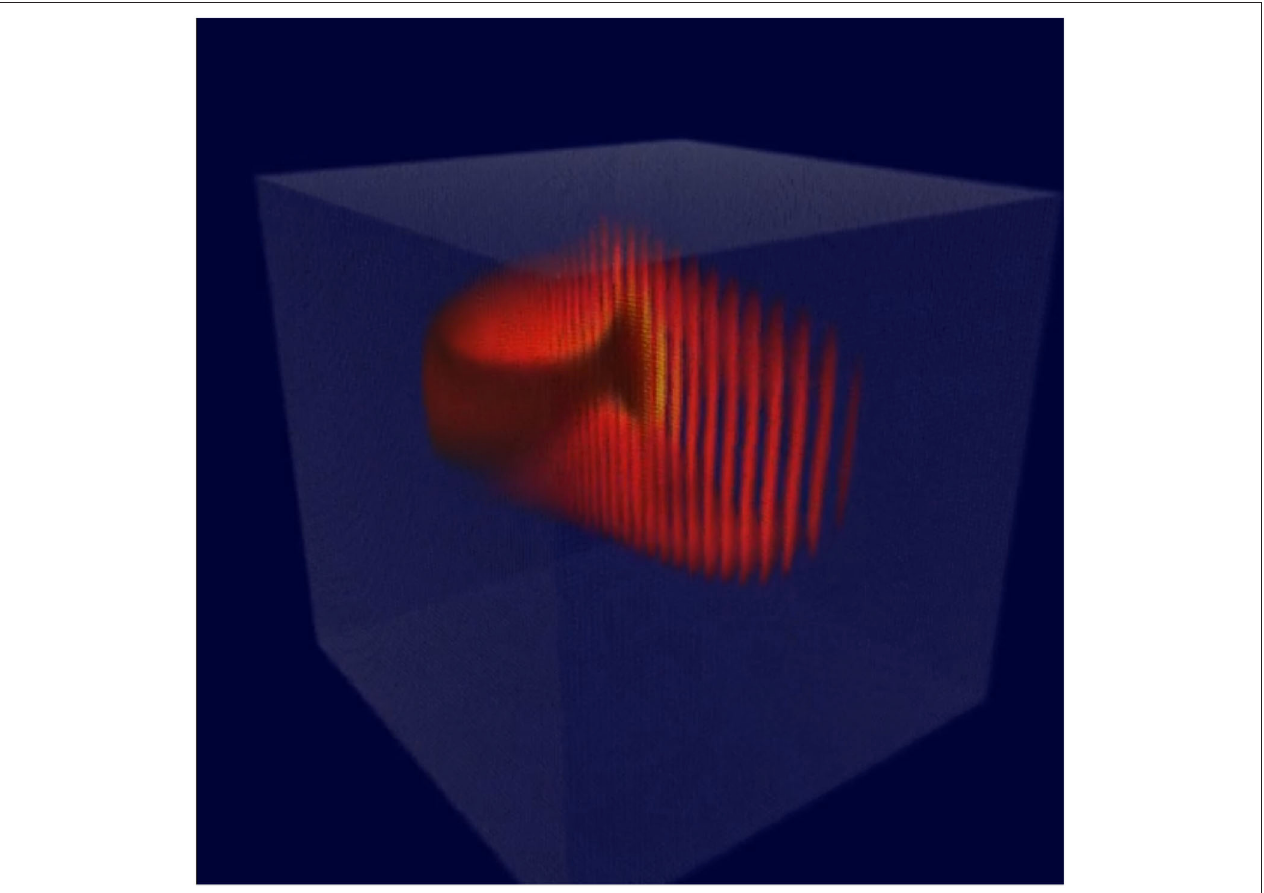
FIGURE 14 | A density plot of a population of Hindmarsh-Rose neurons. The density is contained in a three dimensional volume such that each axis represents one of the time-dependent variables of the model. The volume has been rendered from a rotated and elevated position to more easily visualise the